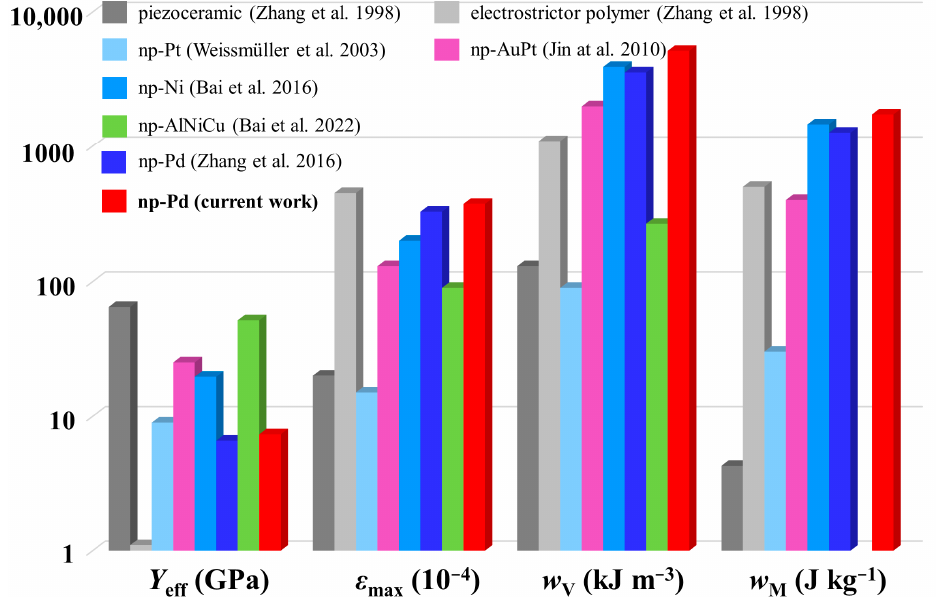
Figure 12. Comparisons of electrochemical actuation performance of various actuator materials [7,9,10,13,16,20,50].